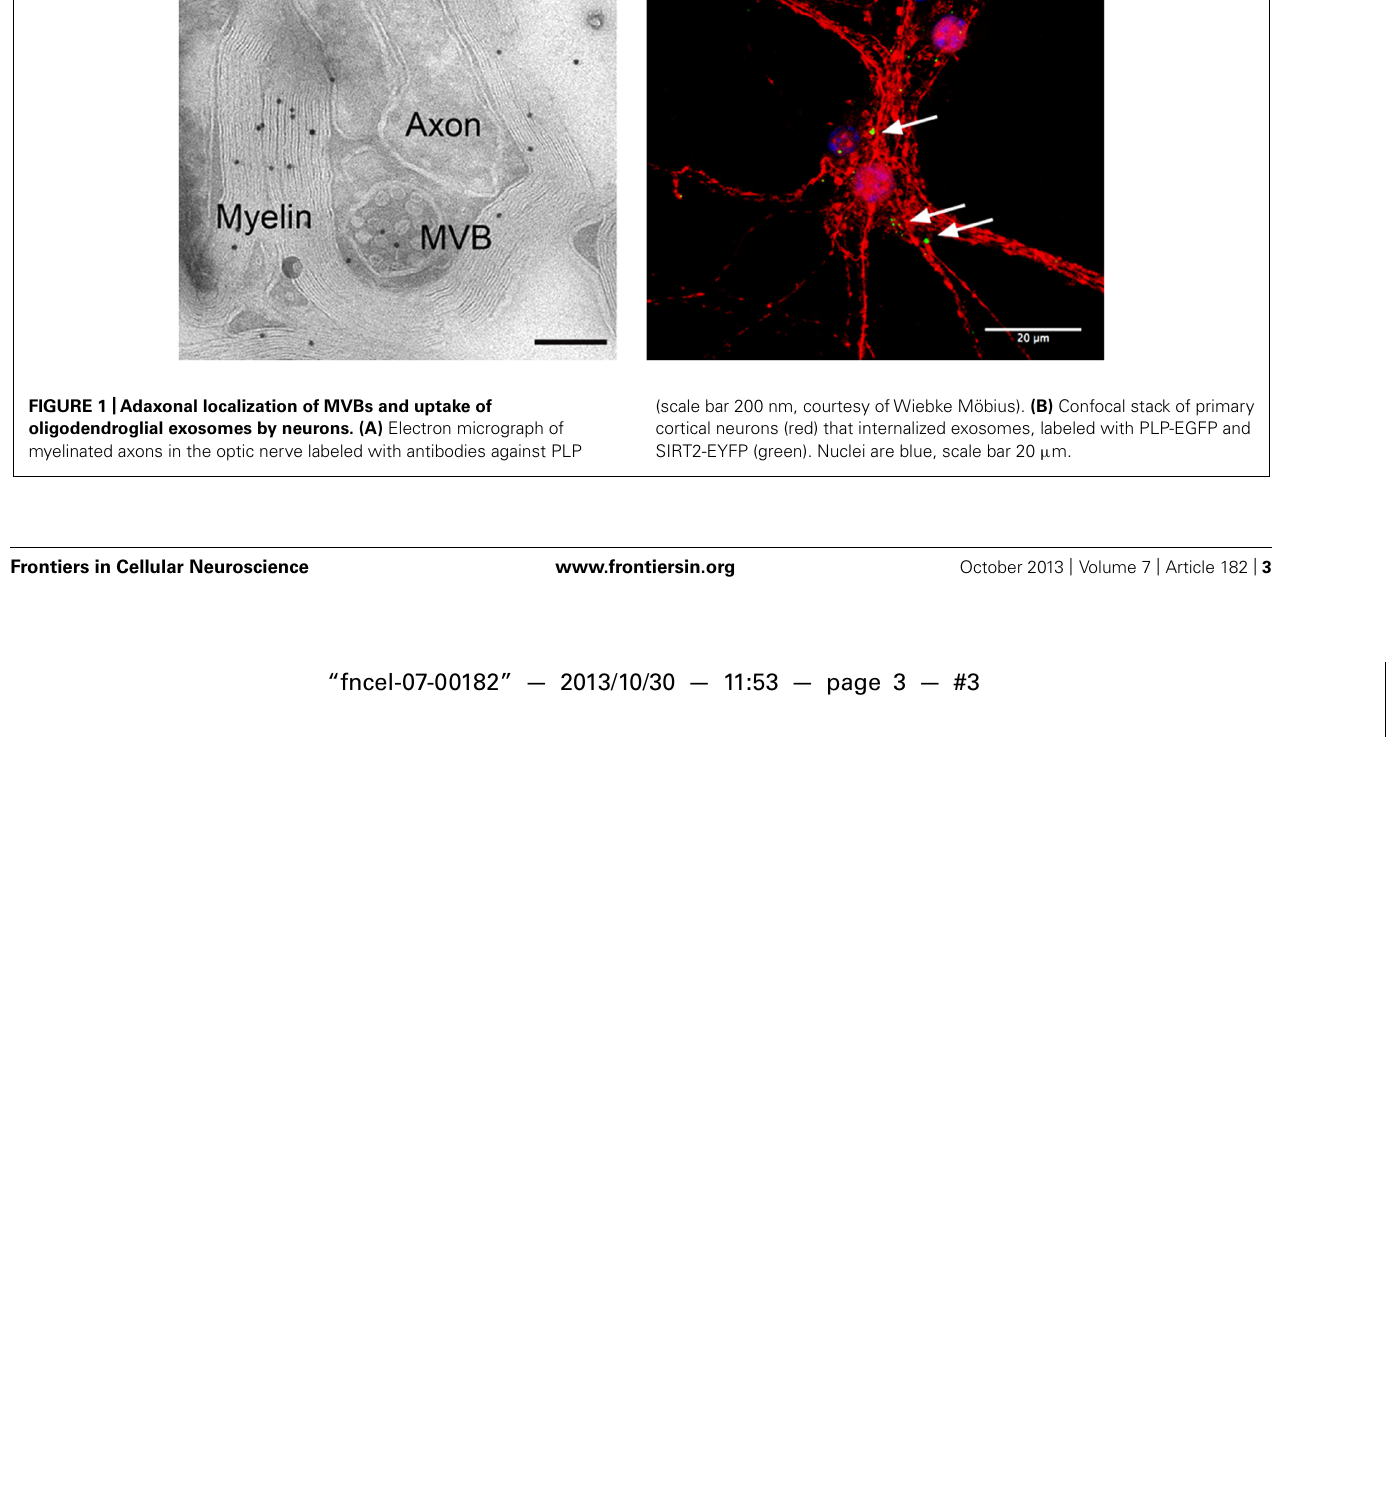
FIGURE 1 |Adaxonal localization of MVBs and uptake of oligodendroglial exosomes by neurons. (A) Electron micrograph of myelinated axons in the optic nerve labeled with antibodies against PLP